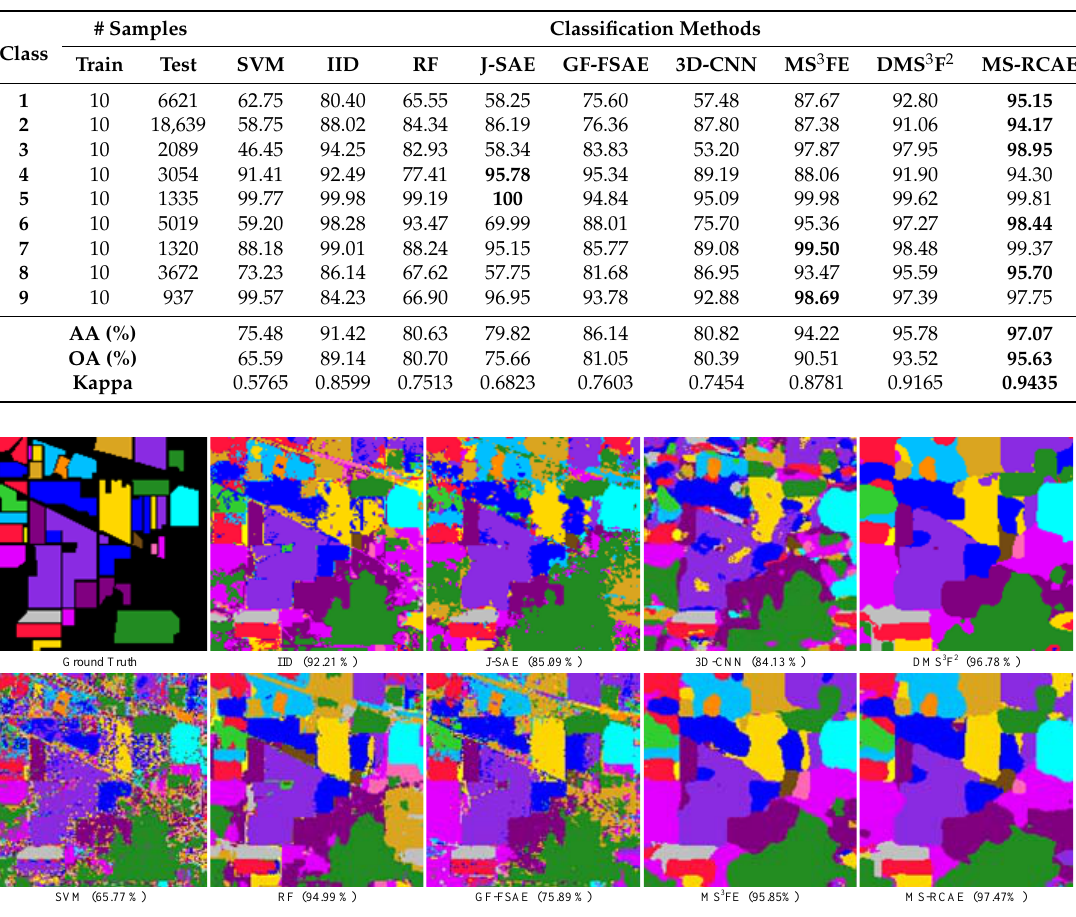
Figure 9. Classification maps of the Indian Pine dataset obtained by different methods